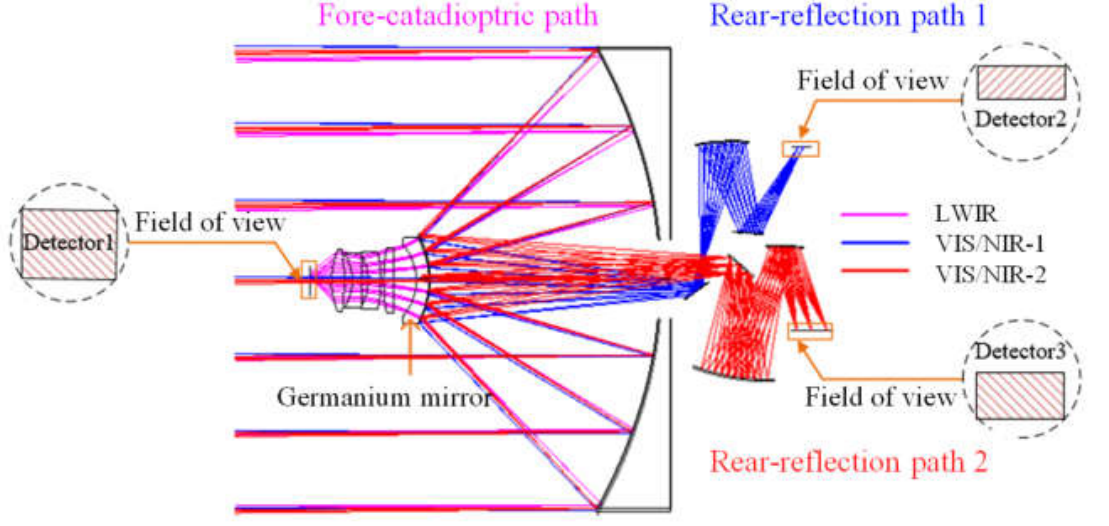
Figure 2. Initial layout of three-dimensional compact system.